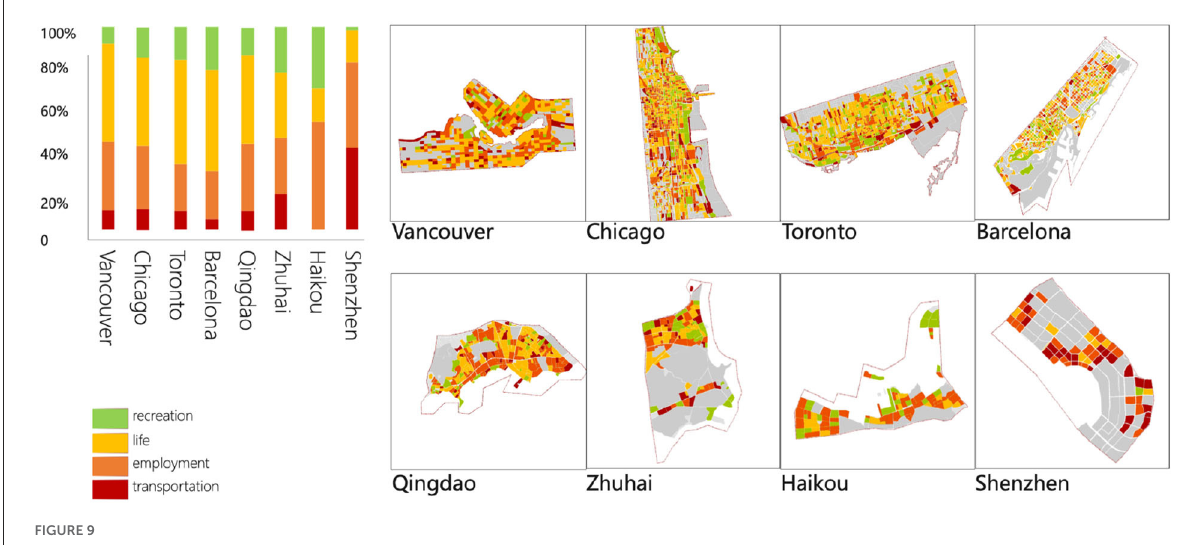
FIGURE9 The proportion of specific functions in the eight case study sites.